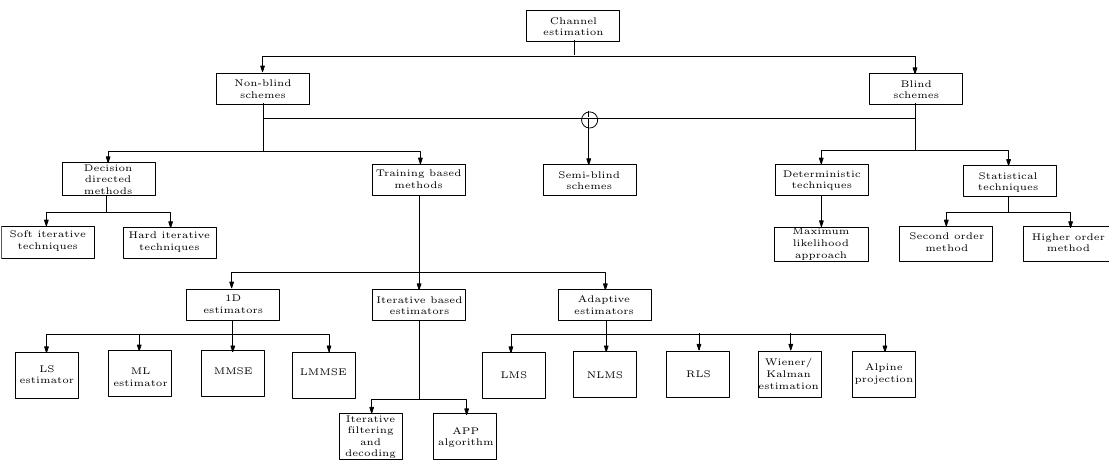
Figure 12. Classification of CE